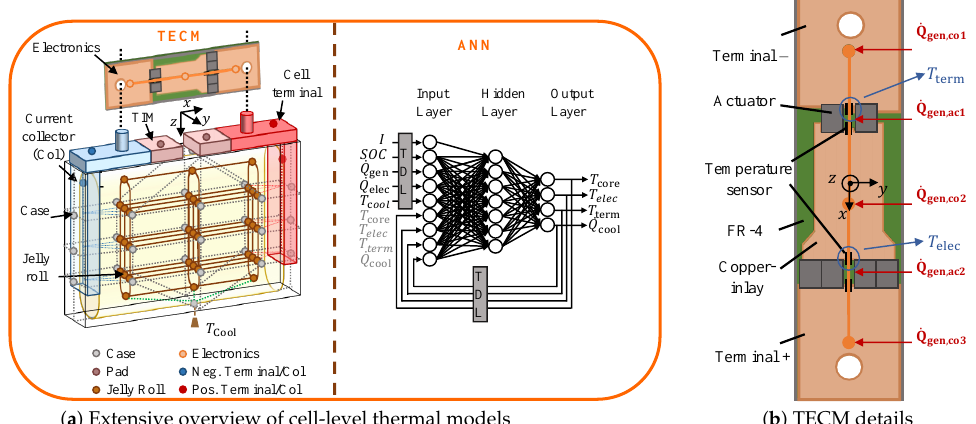
Figure 4. Real-time thermal models for a intelligent cell in a BEV battery system: ( a ) Overview of the TECM and the ANN modeling details. ( b ) Bottom view of the electronics hardware geometry and the related TECM model.